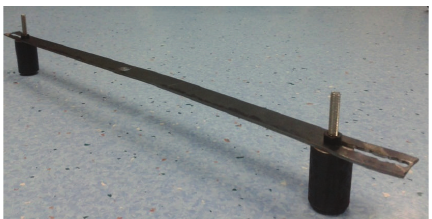
Figure 3: The cantilevered beam absorber with adjustable twin masses.